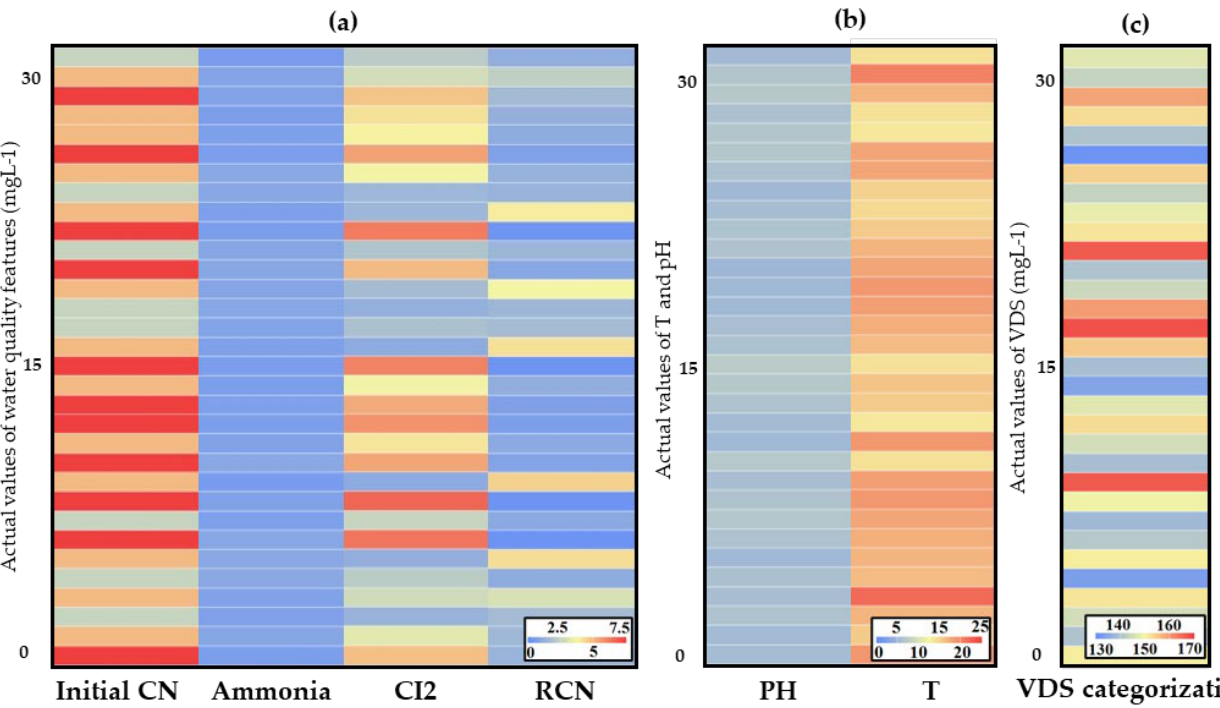
Figure 9. Heat map of available data due to machine learning computations in the present research. ( a ) Initial CN/Injected chlorine, ammonia, and RCN; ( b ) T and pH; ( c ) VDS.